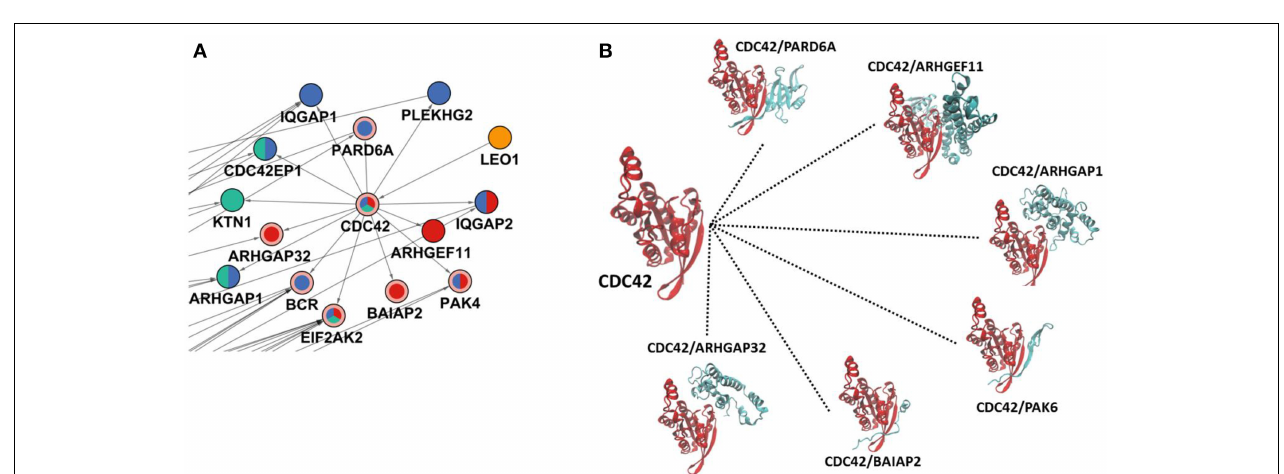
FIGURE 3 | CDC42 and its interactions in the reconstructed network. (A) The region where CDC42 and its first neighbors are located in the reconstructed network. The coloring scheme is the same as in Figure 2 where CDC42, EIF2AK2, BCR, BAIAP2, ARHGAP32, PARD6A, and PAK4 are Steiner nodes and others are